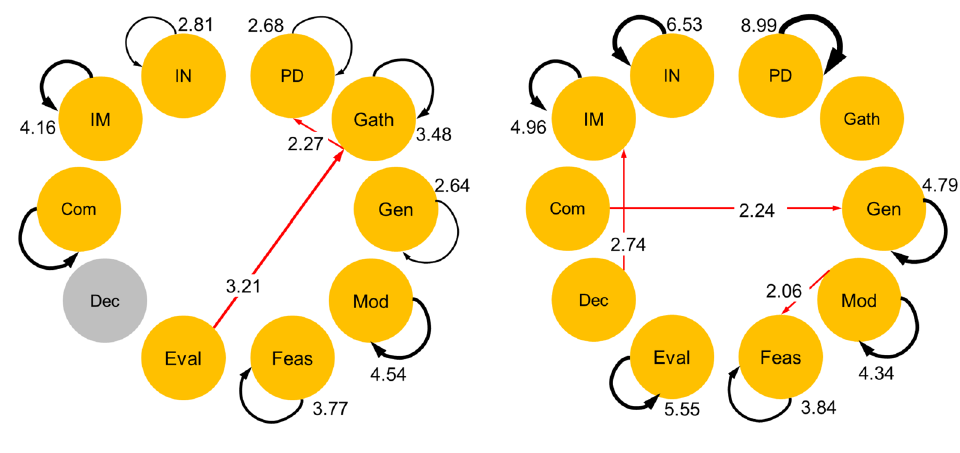
Fig. 6 The behavioral transfer diagrams of the two student